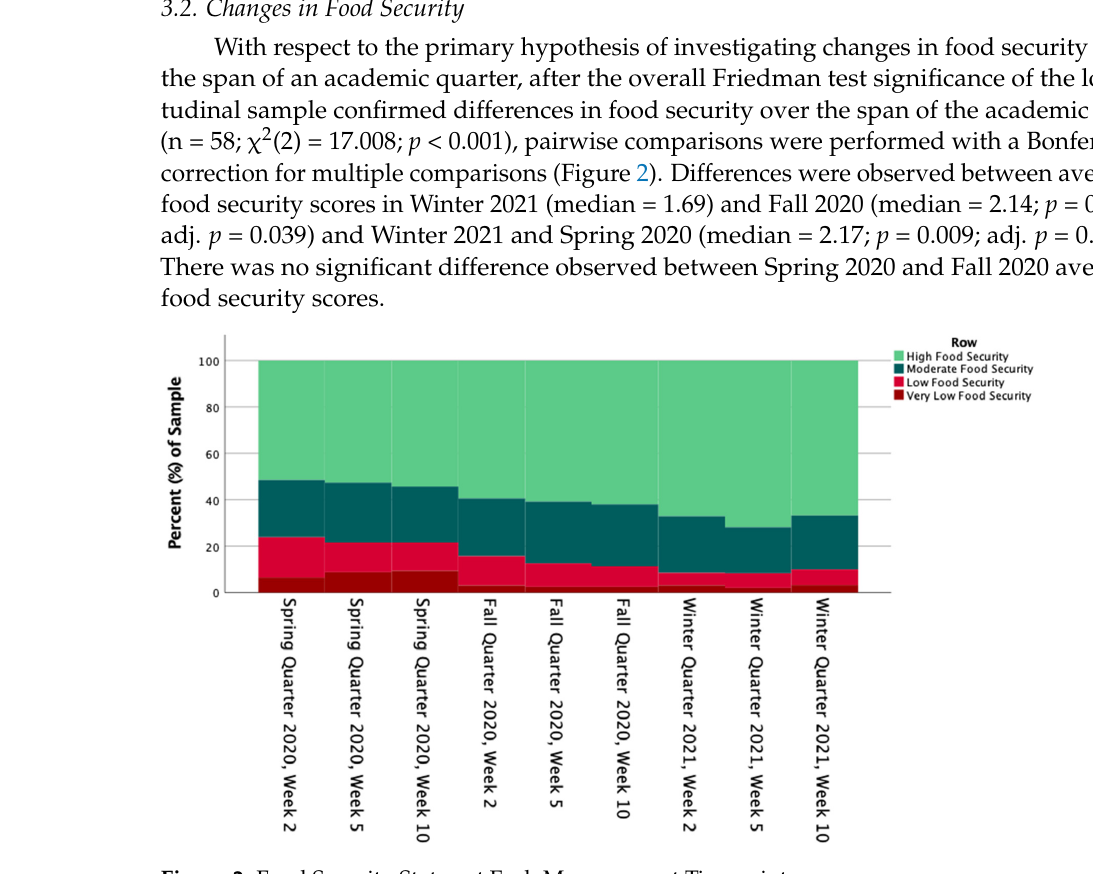
Figure 2. Food Security Status at Each Measurement Timepoint. Post-hoc Friedman analyses indicated differences in raw quarter food security scores. The overall test significance ( χ 2 (2) = 22.607; p = 0.004) and pairwise comparisons were per- formed with a Bonferroni correction. The food security score was different between the Winter 2021, week 5 measurement (median = 4.31) and the Spring 2020 week 2, measure- ment (median = 5.47) ( p = 0.020, adj. p = 0.733). There was no significant difference ob- served between all other food security score measurements. 3.3. CalFresh Participation Moderation of Food Insecurity In a regression-based moderation model, the average food security score was signif- icantly correlated with a decrease in quarter GPA specifically for the Spring and Fall 2020 quarters (Appendixes A and B). During the Spring 2020 quarter, CalFresh participation was not correlated with GPA; however, the interaction of average food security score and CalFresh participation was observed to be positively correlated with quarter GPA, indi- cating a positive moderating effect. These observations remained true after transforming the quarter GPA variable to normalize the outcome variable’s distribution, and in addi- tion, CalFresh participation was negatively correlated with GPA during Fall 2020. When including demographic and academic covariates into the moderation models, the average food security score remained negatively correlated with quarter GPA during the Spring and Fall of 2020 (Table 2; Figure 3). As in the simple moderation model, the interaction of average food security score and CalFresh participation was observed to be significant, indicating a positive moderating effect of CalFresh participation on food secu- rity’s effect on GPA.